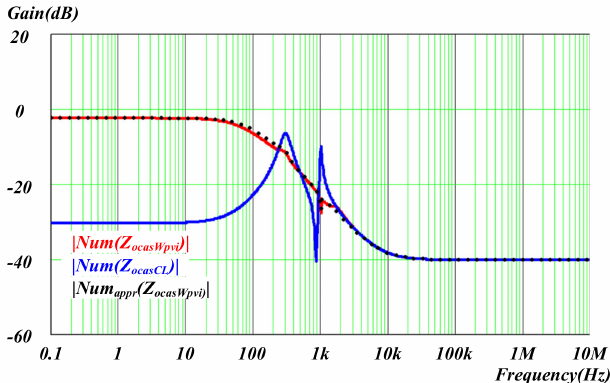
Figure 20. Bode plot of | Num(Z ocasWpvi ) | , | Num appr (Z ocasWpvi ) | and | Num(Z ocasCL ) |